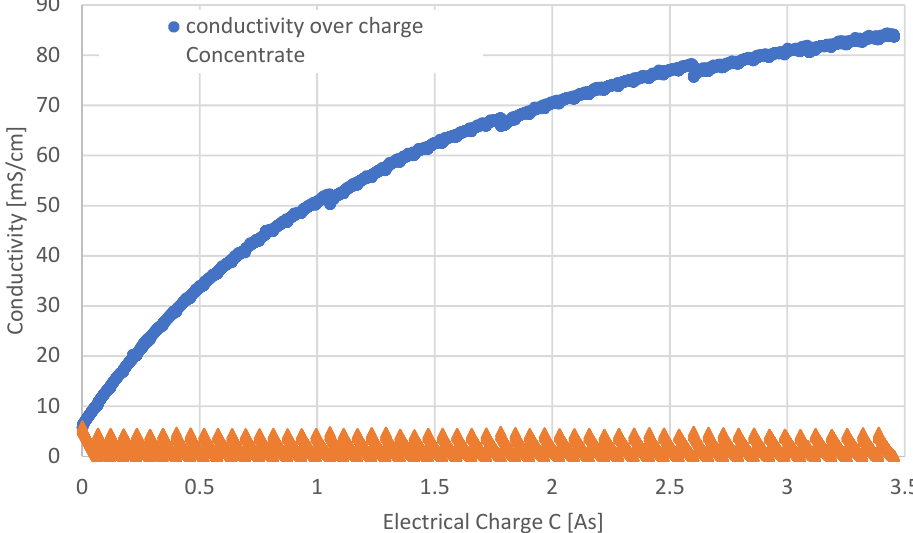
Figure 2. Conductivity during the long-term experiment over 17.5 h at ϑ = 21 °C as a function of the electrical charge. Initial diluate and concentrate concentrations were 3 g/L LiCl.